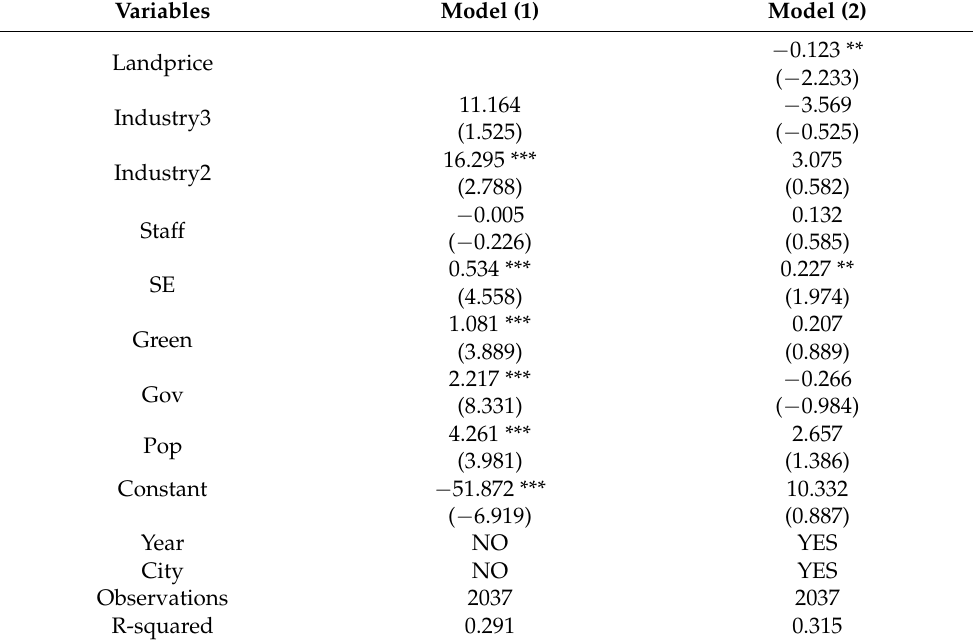
Table 4. Regression results of land transaction price and urban carbon